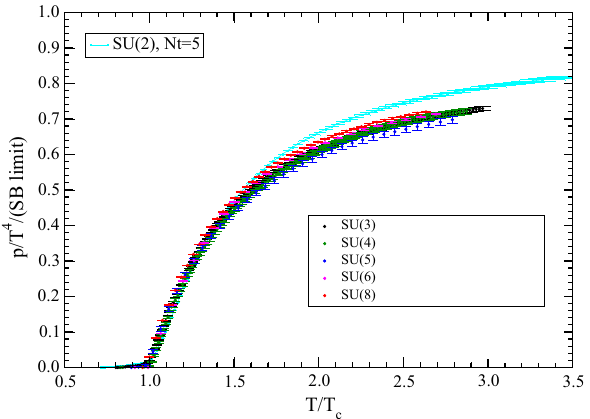
Fig. 19 Comparison of the pressure in the confined phase, measured in this work (cyan line), with data taken from Ref. [52] (green